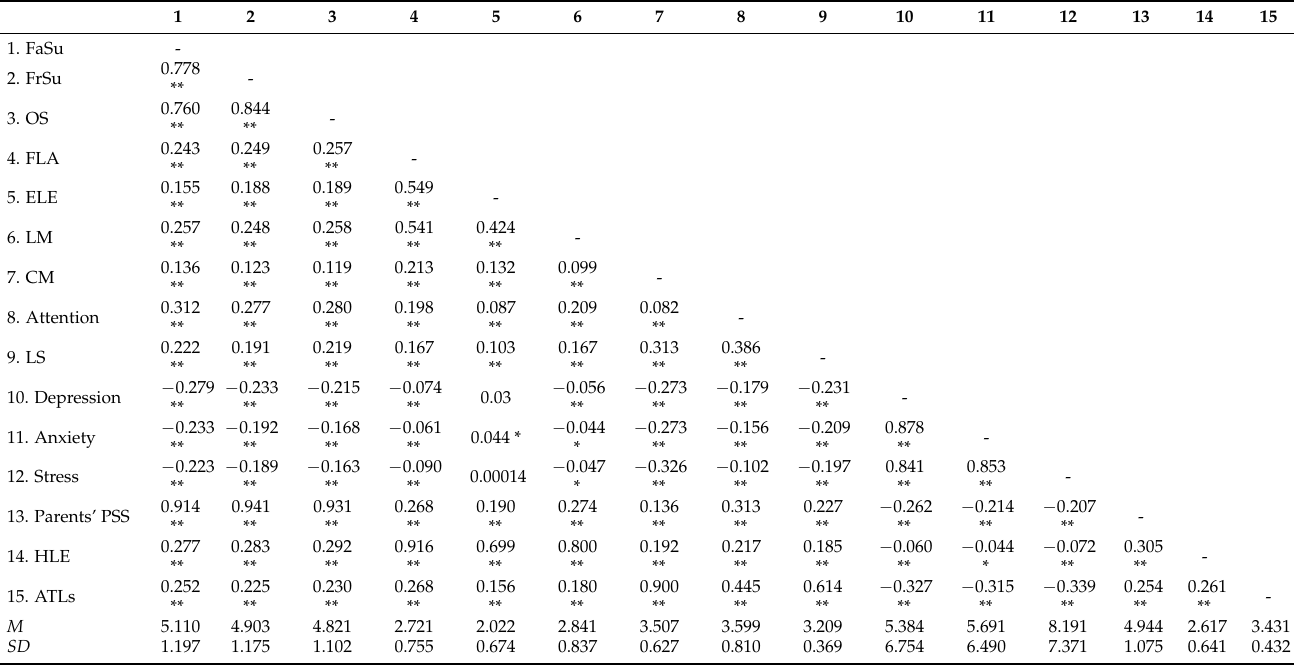
Table 1. Descriptive statistics and correlations among